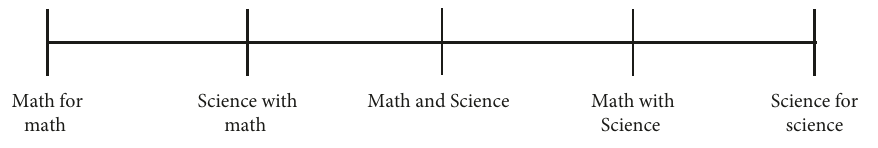
Figure 1: Continuum included in the